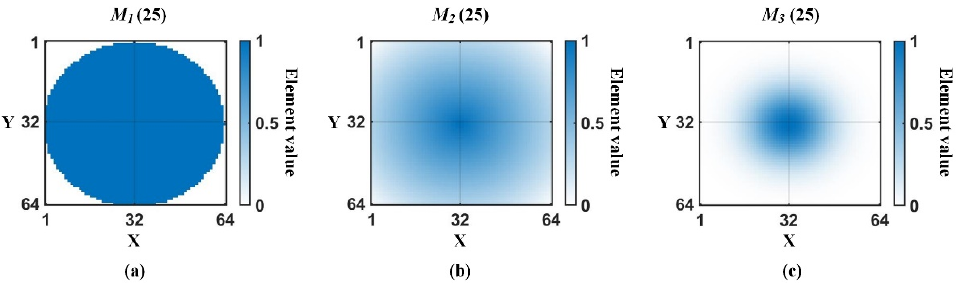
Figure 4. Values of the elements of ( a ) M 1 ( 25 ) for cut-type filtering, ( b ) M 2 ( 25 ) for linear-type filtering and ( c ) M 3 ( 25 ) for Gaussian-type filtering.